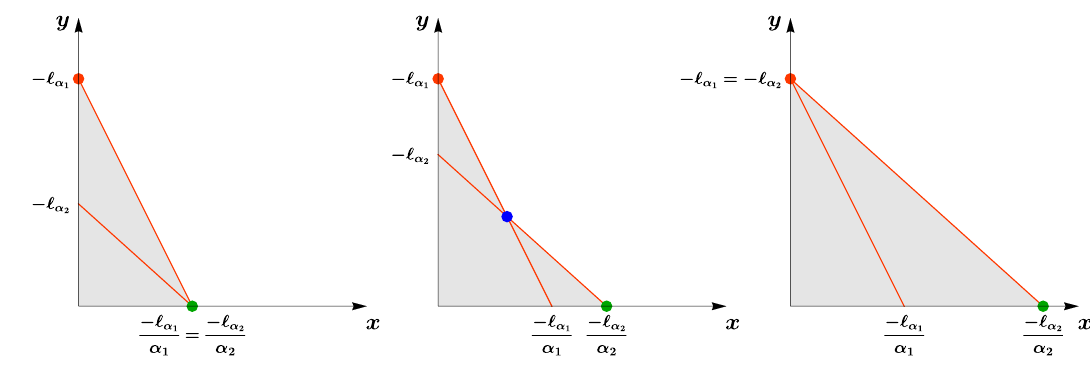
Figure 2 . The measurement of two angularities ‘ (cid:11) 1 and ‘ (cid:11) 2 represented in the Lund plane. Each panel describes a distinct region of phase space. The left and right panels involve only collinear (green) and soft (orange) modes, while the center panel contains an additional collinear-soft (blue) mode. Emissions in the shaded region are